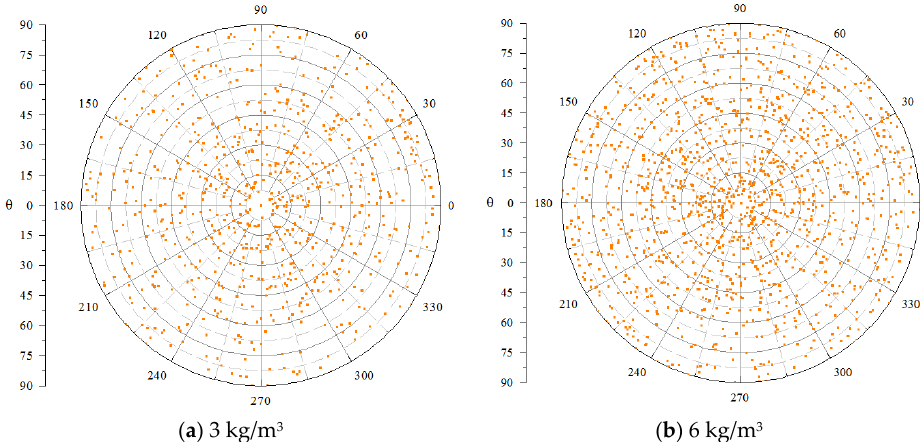
Figure 10. The distribution of fiber angle.